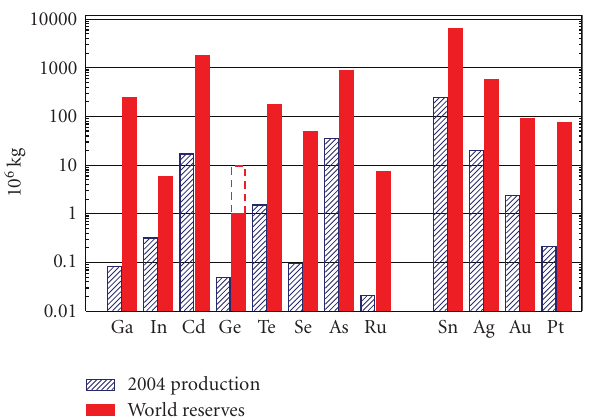
Figure 1: Estimated 2004 annual production levels and material reserves for various materials used in PV industry (from